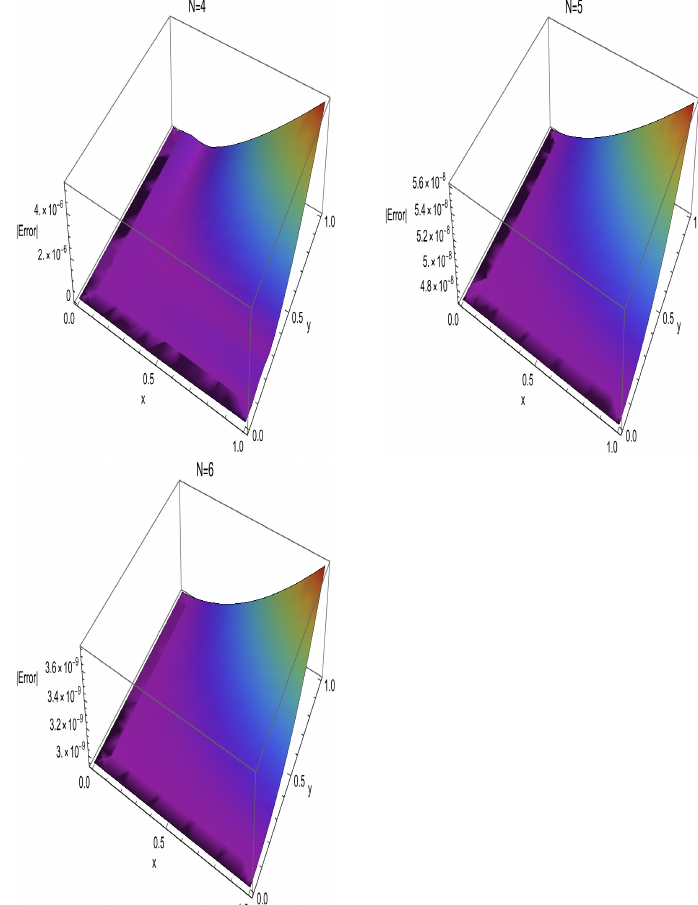
Figure 1. The absolute errors with ( u , v , ρ 1 , ρ 2 ) = ( 2/5,1/4,5,4 )